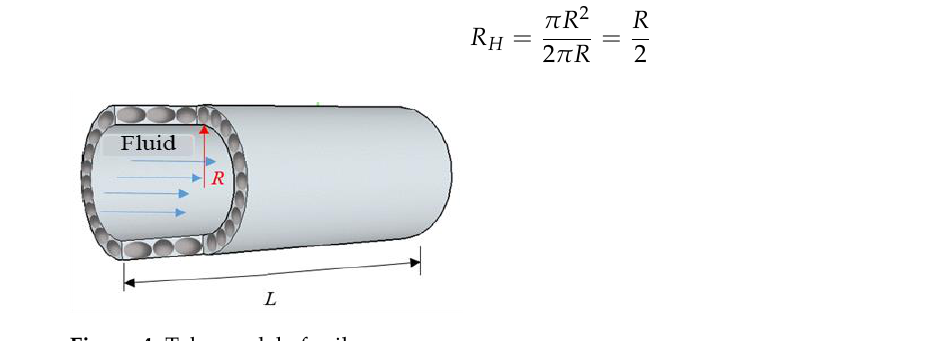
Figure 4. Tube model of soil seepage.